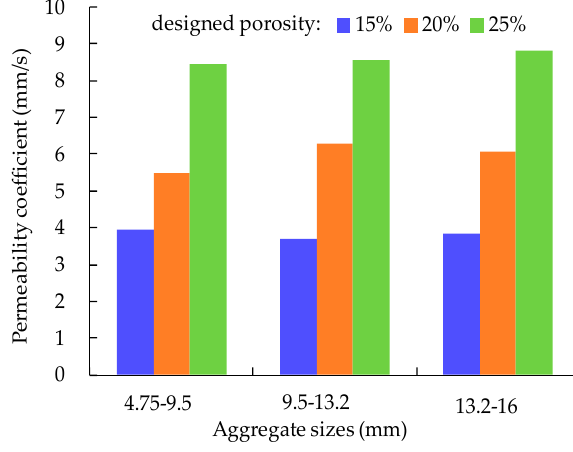
Figure 7. Relationship between permeability coefficient, designed porosity and aggregate size.